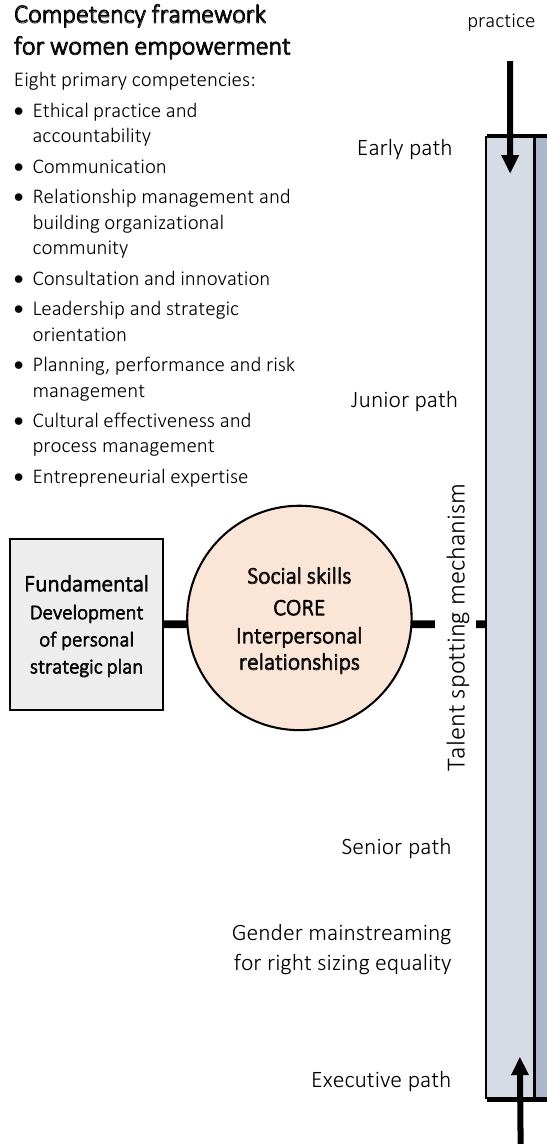
Figure 2. Competency framework for women